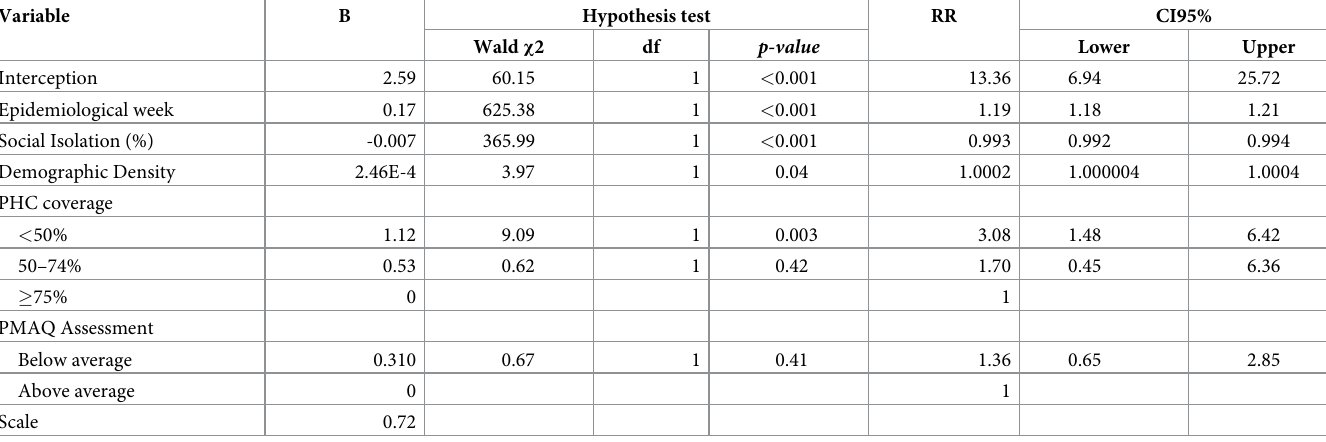
Table 4. Adjusted model for the association with incident COVID-19 cases in the time-series of twenty epidemiological weeks in Northeastern cities in Brazil. Variable B